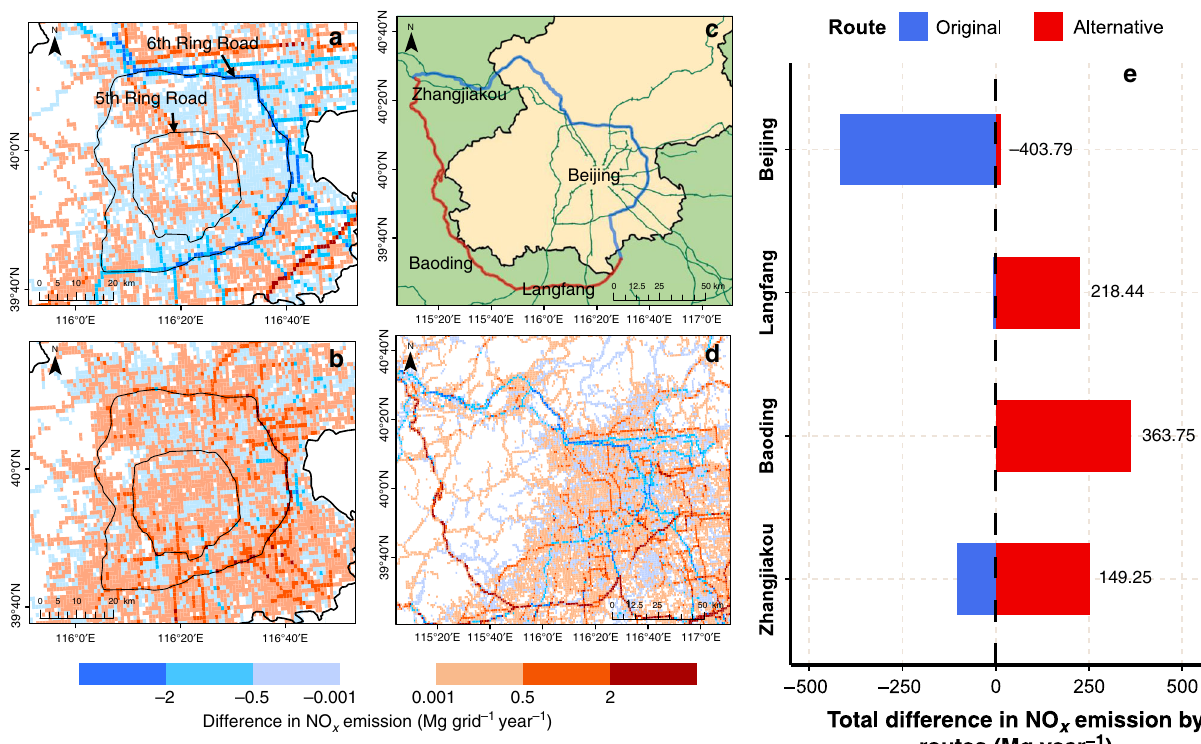
Fig. 6 Differences in the high-resolution (0.01 ˚ × 0.01 ˚ ) maps of NO x emissions by HDTs between 2017 and 2018. a Two-year differences in emissions by non-local HDTs in the core of Beijing. The two black lines circling the city are the 5th Ring Road and 6th Ring Road (LEZ ’ s range), which are identi fi ed by arrows and labelled. b Two-year differences in emissions by local HDTs in the core of Beijing. c Illustration of the alternative route (red line) and original route (blue line) in the LEZ. The names and locations of the four cities along these two routes are labelled in black. d Difference in gridded NO x emissions of HDTs along the alternative and original routes over two years. e Comparison of the total differences in NO x emissions by HDTs between the four cities in two years. The numbers in ( e ) represent the total net differences in HDT emissions. *Source data are provided as a Source Data fi